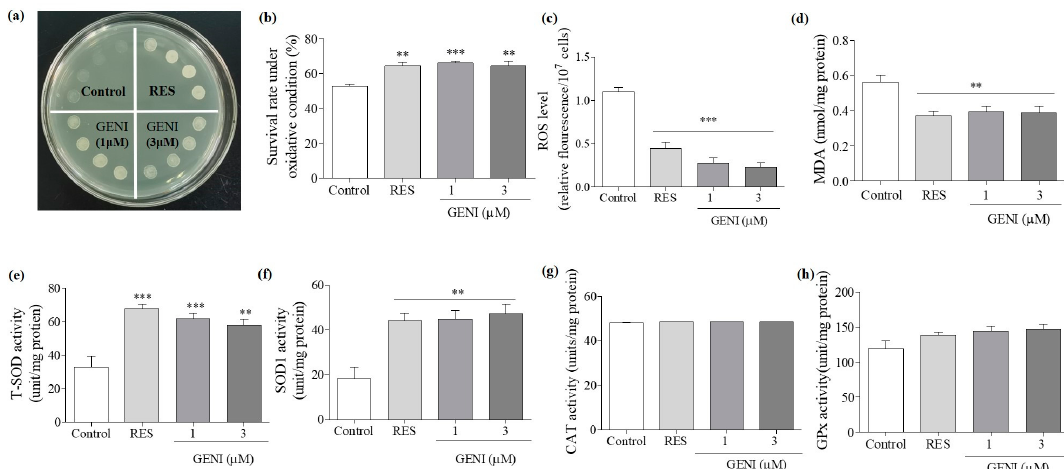
Figure 3. Effect of GENI on the survival rate of yeast under oxidative stress condition and anti-oxidative enzyme activity in yeast. ( a ) Photograph of yeast growth after treatment of GENI under oxidative stress condition induced by H 2 O 2 at 9.5 m. ( b ) The survival rate changes in yeast under oxidative conditions at 5 mM H 2 O 2 . ( c , d ) Effect of GENI on ROS and MDA levels. ( e – h ) The changes on T-SOD, SOD1, CAT, and GPx enzyme activities in yeast after treatment of GENI for 24 h. Experiments were repeated thrice, and the data are presented as means ± SEM. ** p < 0.01 and *** p < 0.001 represent significant difference compared with the control